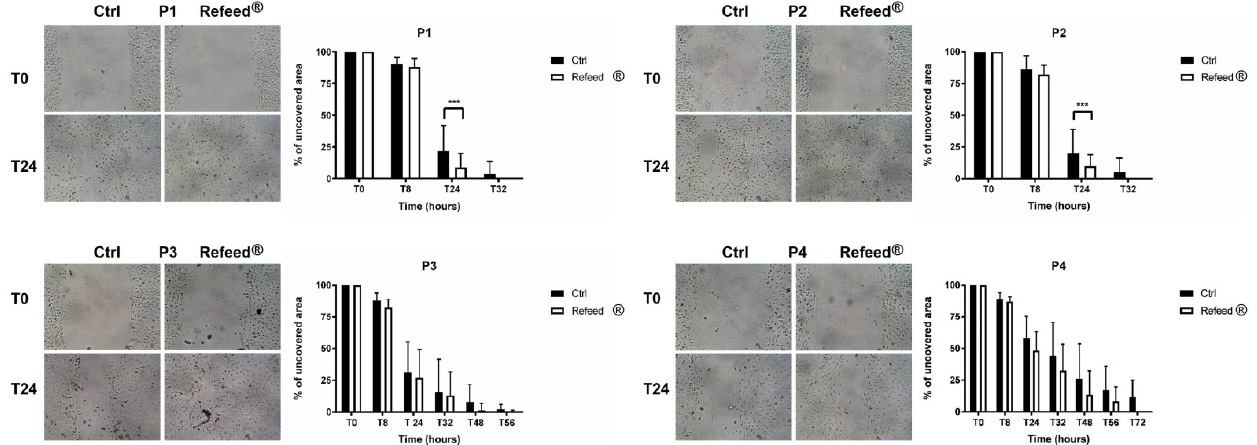
Figure 8. Migratory capacity of human Amniotic Epithelial Cells (hAECs) cultured with and without Refeed ® supplementation. For each passage (P1–P4), representative images of hAEC monolayer cultured with (Refeed ® ) or without (Ctrl) Refeed ® and the analysis of the scratch area are reported for both conditions. Images were acquired immediately after the scratch (T0) and 24 h after (T24), using the optical microscope Leica Labovert FS inverted Microscope equipped with a Leica MC170 HD digital camera. The percentage of the uncovered area of hAECs in basal medium (Ctrl) and with Refeed ® supplement was evaluated at the beginning of the assay (T0) and at different time points (T8, T24, T32, T48, T56, T72) until scratch was closed. The uncovered area at T0 is set to 100% for both conditions. Results are expressed as mean ± standard deviation (SD) (*** p < 0.001). The experiment was performed on three human samples in technical triplicate.